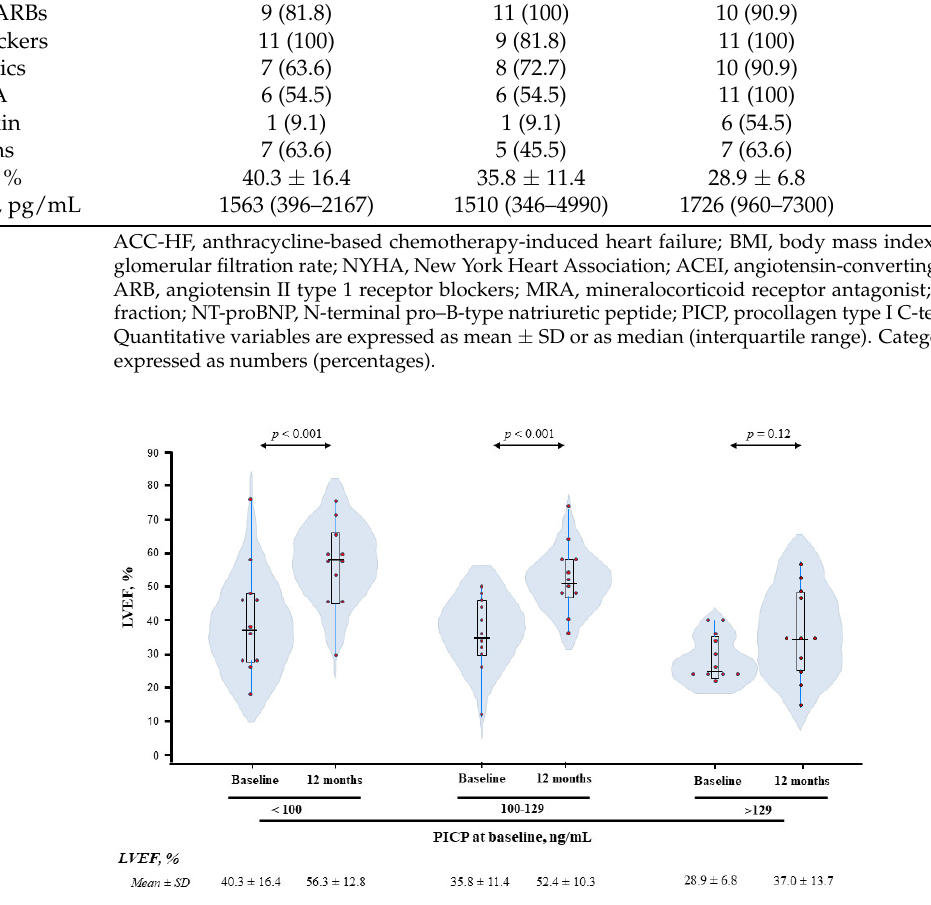
Figure 6. PICP levels at baseline and 1-year changes in LVEF in ACC-HF patients. Violin plots depict LVEF at baseline and after 12 months of follow-up in ACC-HF patients categorized according to tertiles of baseline PICP. Red dots are individual values, horizontal lines indicate medians and boxes indicate interquartile ranges. PICP, procollagen type-I C-terminal propeptide; LVEF, left